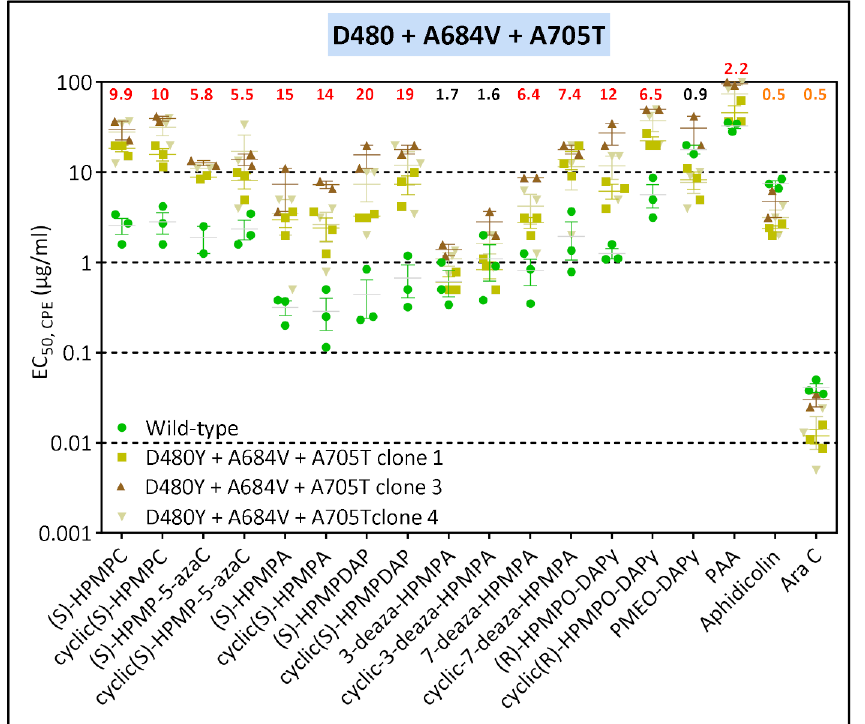
Figure 7. Drug-susceptibility profile of selected VV2 HPMPDAP-R viral clones to evaluate the impact of the D480Y, A684V, and A705T DNA polymerase substitutions. The source of the viral clones was as follows: D480Y (VV2 HPMPDAP-R # 4), and D480Y + A684V + A705T (VV2 HPMPDAP-R #36). Drug-resistance properties of the different types of viral clones were determined using a CPE reduction assay with HEL fibroblasts. The effects of different drugs on viruses encoding the indicated mutations were determined by calculating the EC 50 values for the parental wild-type strain and clones bearing the specific mutations. At least two independent experiments were performed for each test compound. Horizontal lines for each drug and mutant viral clones indicate the mean values ± standard deviation. The fold resistance (ratio of the EC 50 for the mutant viruses to the EC 50 for the corresponding wild-type virus is marked at the top of the graph. VACV viral clones showing a ≥ 2-fold increase (red, bold) were considered drug resistant (R) and those with a ≤ 0.5-fold decrease (orange, bold) drug hypersensitive